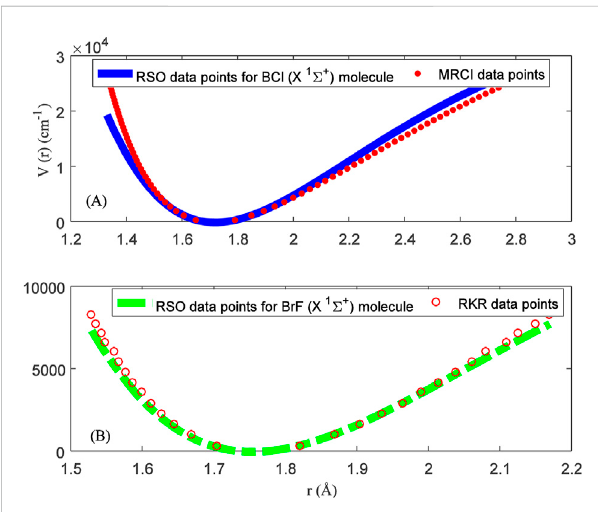
FIGURE 1 Modeling of reparameterized Scarf II oscillator to (A) multireference con fi guration interaction curve for the BCl (X 1 Σ + ) molecule. (B) Rydberg-Klein-Rees internuclearpotential energycurve for the BrF (X 1 Σ + ).